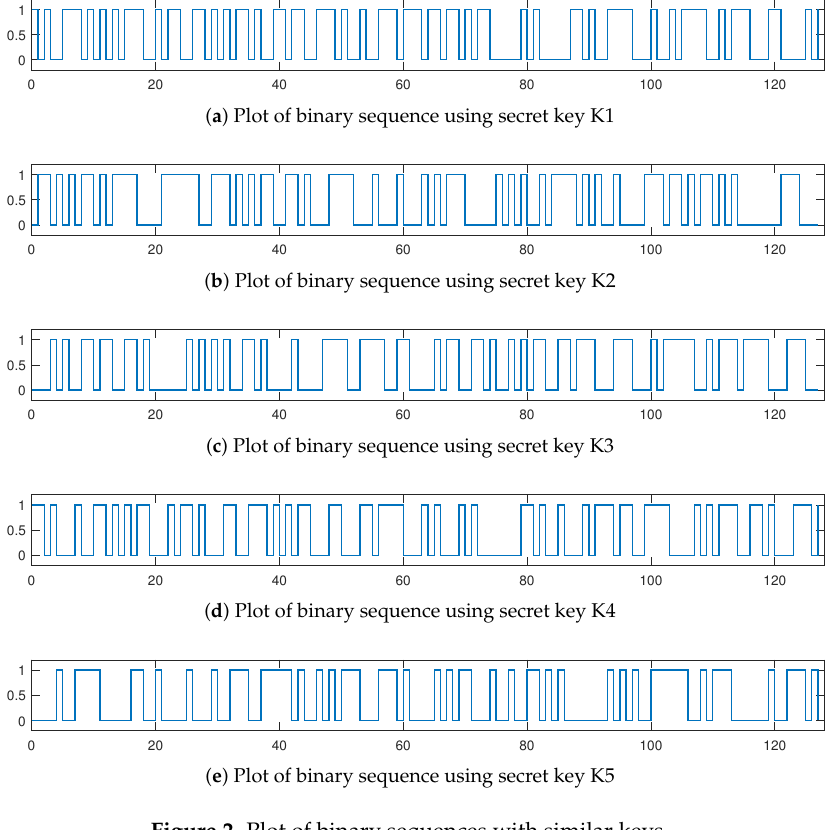
Figure 2. Plot of binary sequences with similar